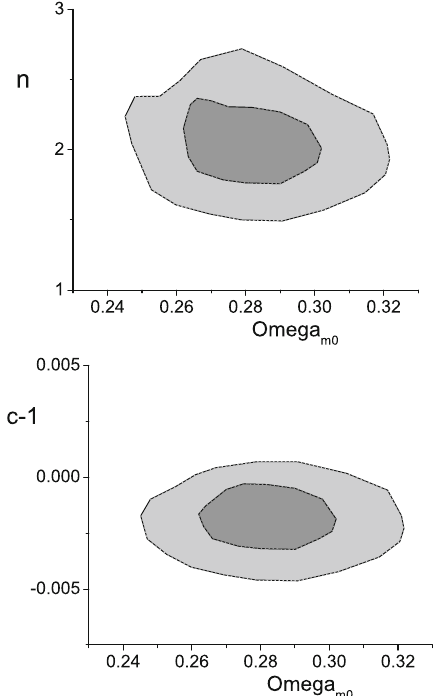
Fig. 2 The 1 σ and 2 σ 2-dimensional contour plots for the parameters n (upper graph) and c (lower graph) in terms of the current value of the matter density parameter (cid:10) m 0 , for the scenario of modified cosmology through non-extensive thermodynamics with varying exponent, using SNIa and H ( z ) data